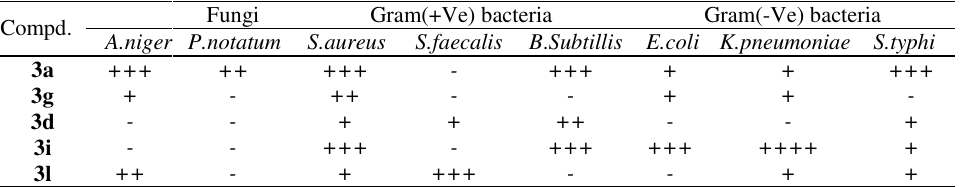
Table 2. Antimicrobial screening results of synthesized indole compounds Fungi Gram(+Ve) bacteria Gram(-Ve) bacteria